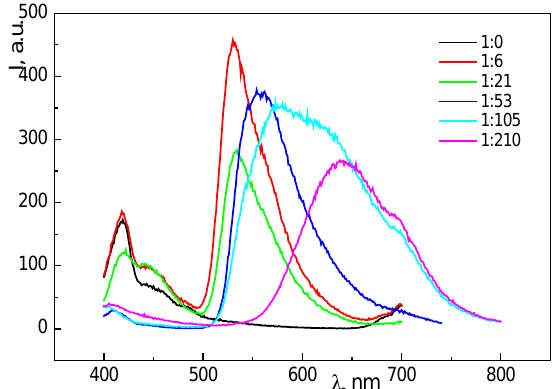
Figure 5. Fluorescence spectra of thiazole orange (TO) intercalated into DNA-2 ( λ ex = 320 nm; the molar ratio of DNA-2 to TO is shown in the legend).